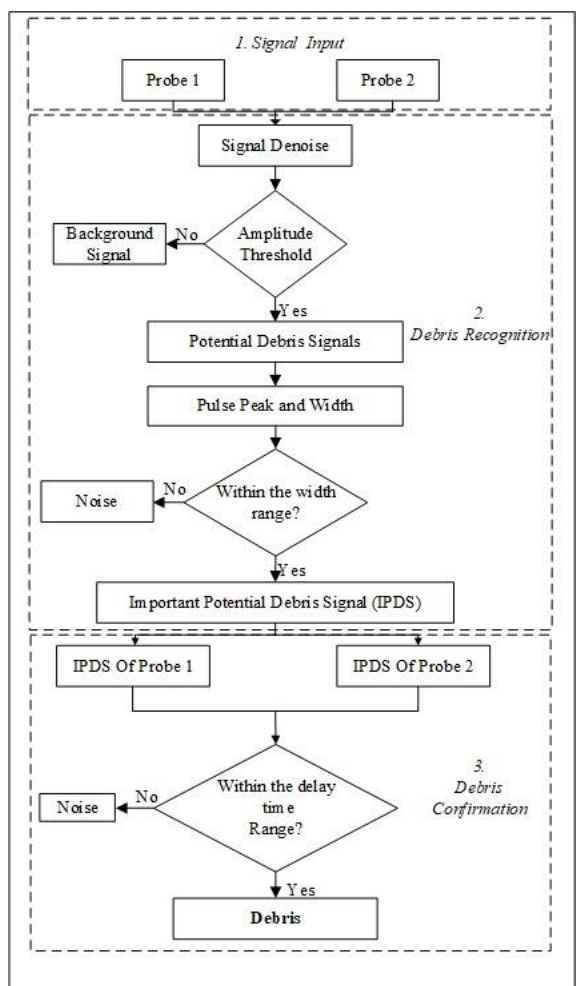
Figure 5. Debris identification method.